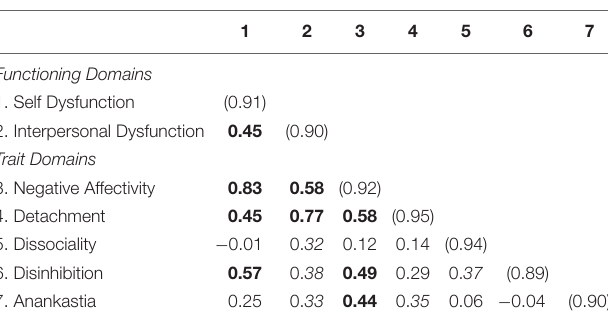
deviation. AIC, Average interitem correlation. TABLE 3 | ICD-11 personality disorder-severity and trait domain scale